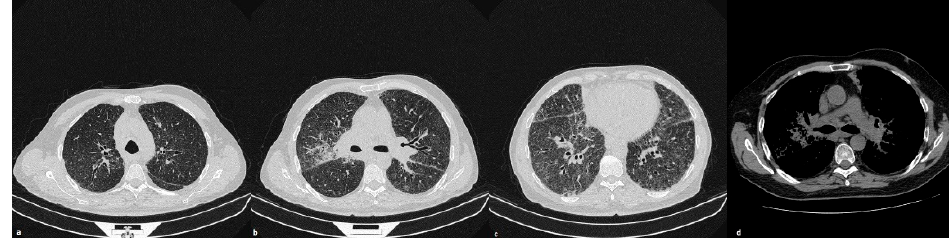
Figure 1. A patient affected by pulmonary sarcoidosis. Axial scan passing through the bases ( a ), through the origin of the pulmonary artery ( b ) and through the apices ( c ), lung windows settings: tiny nodules distributed in a random hiliary-like manner are shown; ( d ) using the mediastinum window settings it is possible to appreciate the presence of bilateral symmetric hilar lymphadenopathy.